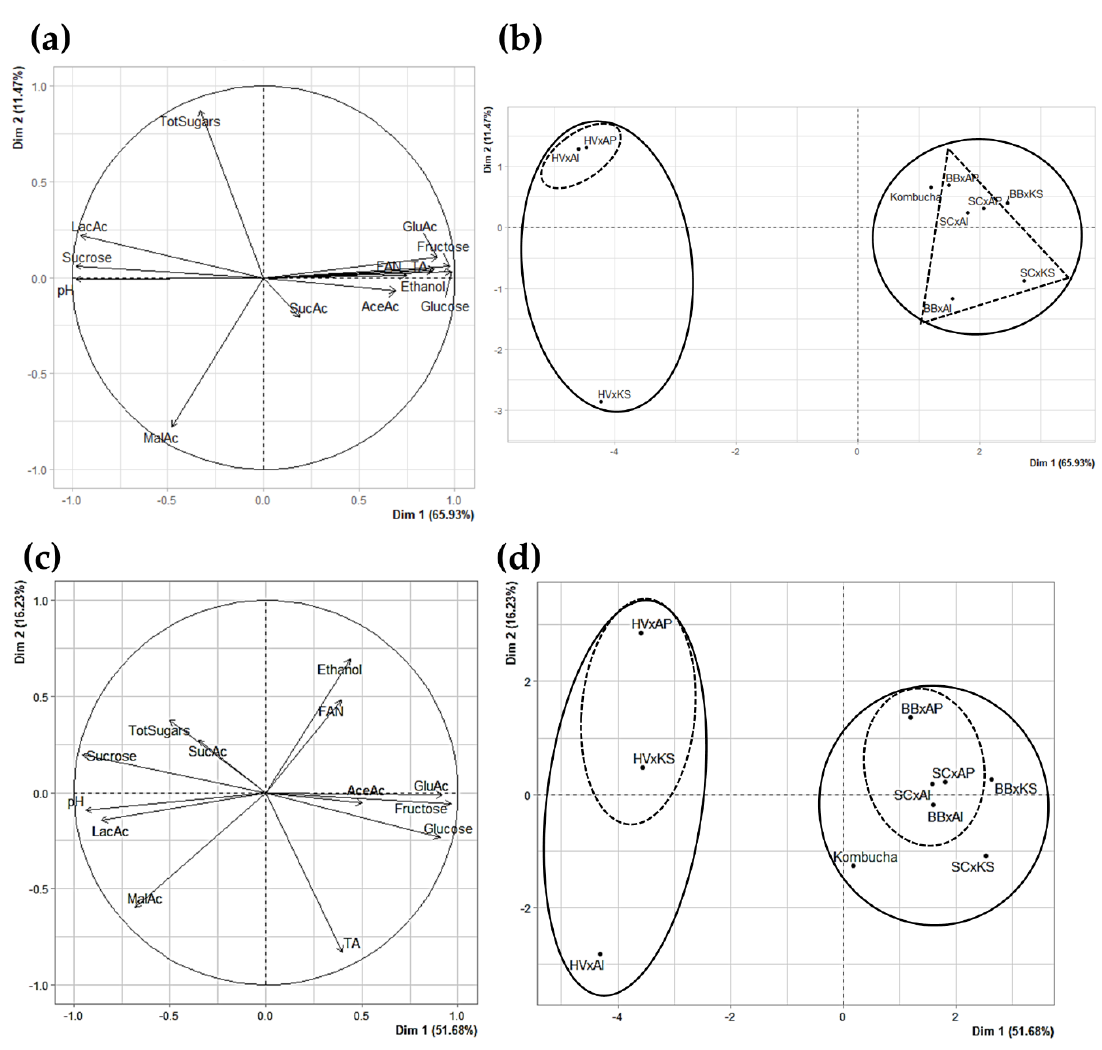
Figure 8. Principle Component Analysis of coculture and original kombucha samples using parameters of the chemical composition. ( a ) Parameter or vector plot for P1, ( b ) sample plot for P1, ( c ) parameter or vector plot for P2, and ( d ) sample plot for P2. Continuous circles gather samples of the same primary clusters and dashed line circles gather samples of the same sub-clusters according to hierarchical ascendant clustering analysis.